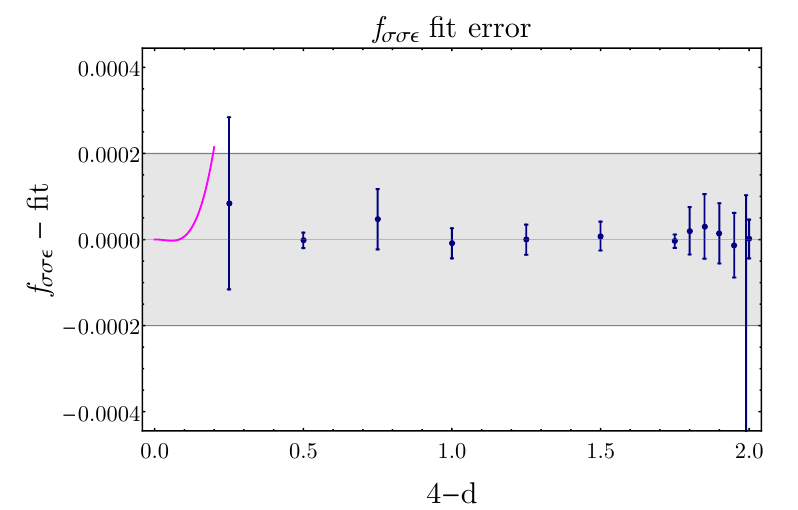
Figure 10 . Fit of structure constant f (cid:27)(cid:27)(cid:15) with bootstrap data (blue) with overall error (gray) and epsilon expansion (magenta) [31,